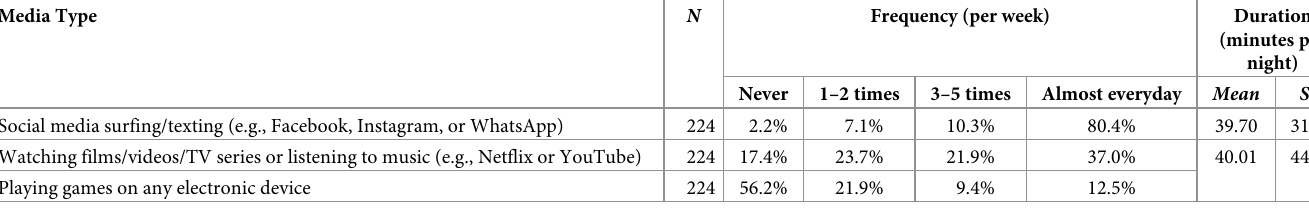
Table 3. Frequency and duration of bedtime media use by media type.